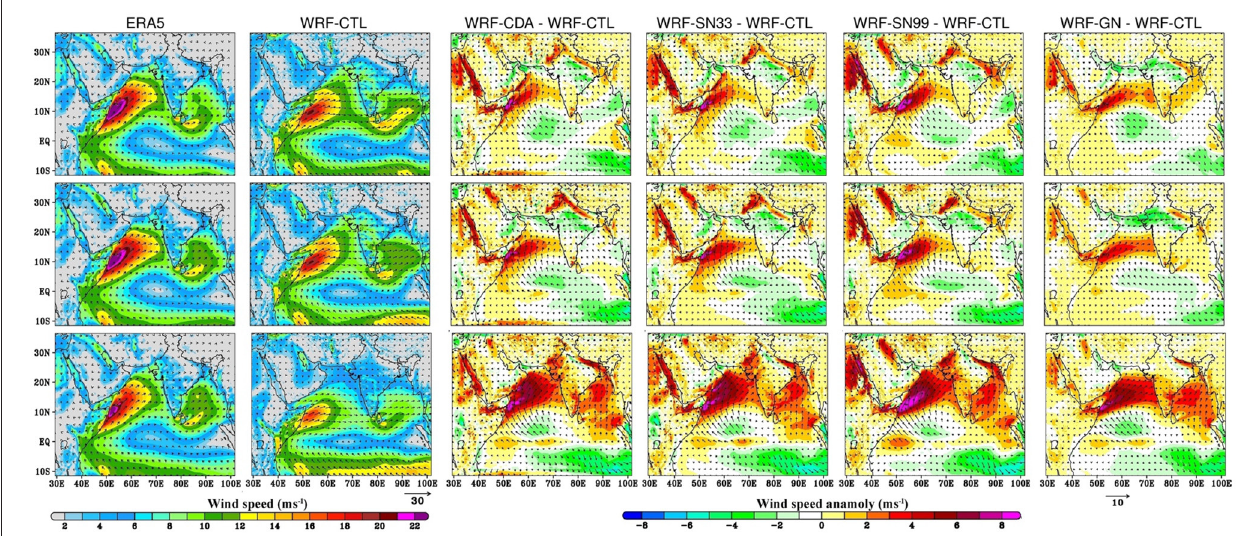
FIGURE 4 | The mean seasonal winds (m/s) at 950 hPa of ERA5 (First column) and WRF-CTL (Second column), and the differences in the mean zonal wind shear (m/s) between the WRF-CDA and WRF-CTL (Third column), WRF-SN33 and WRF-CTL (Fourth column), WRF-S99 and WRF-CTL (Fifth column), and WRF-GN and WRF-CTL (Sixth column) during normal (2016), excess (2013), and drought (2009) Indian Summer Monsoon seasons. First row is for normal, second row is for excess, and third row is for drought Indian Summer Monsoon seasons.